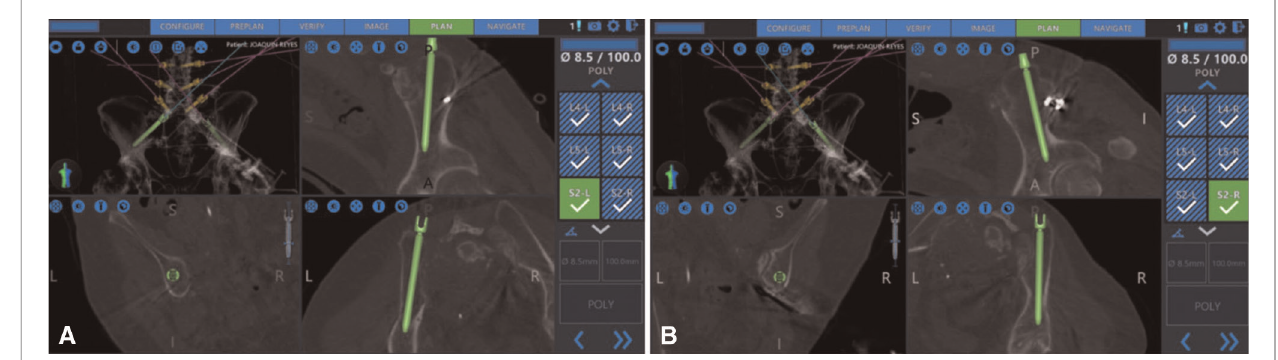
FIGURE 3 | Navigated placements of the right ( A ) and left ( B ) iliac bolts (8.5×100 mm) (from (22), used with